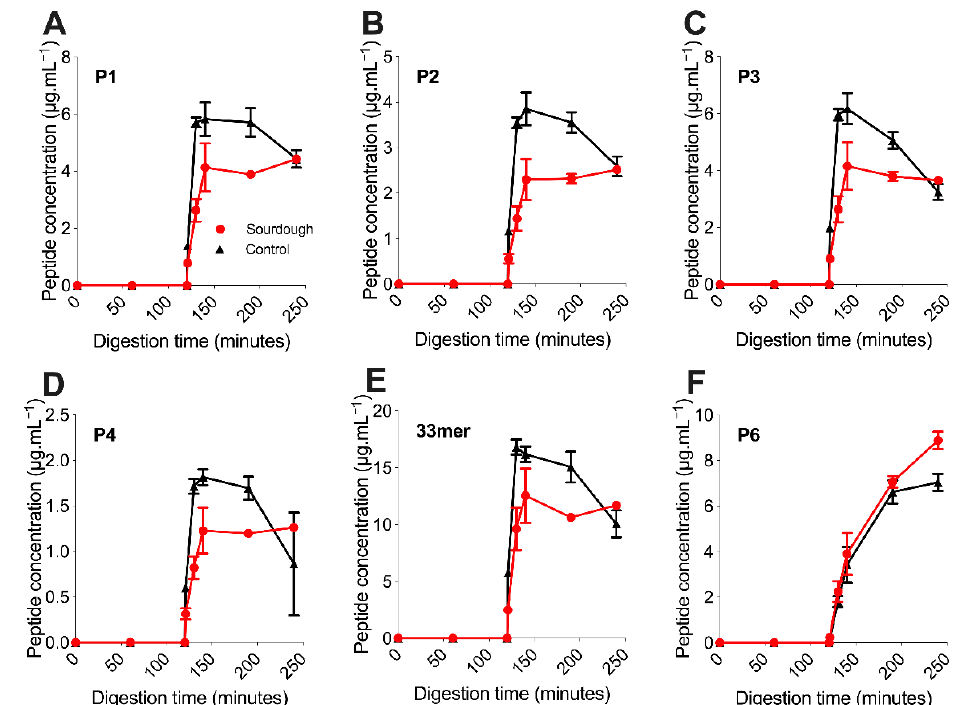
Figure 2. The release profiles of six key immunogenic gluten peptides throughout the in vitro digestion of sourdough (red) and fast fermentation control (black) breads. Peptide concentration determined by targeted LC-MS. ( A ) Peptide P1, ( B ) peptide P2, ( C ) peptide P3, ( D ) peptide P4, ( E ) peptide P5/33mer, and ( F ) peptide P6. All samples were digested and analysed in triplicate. Error bars display the standard deviation of the mean.